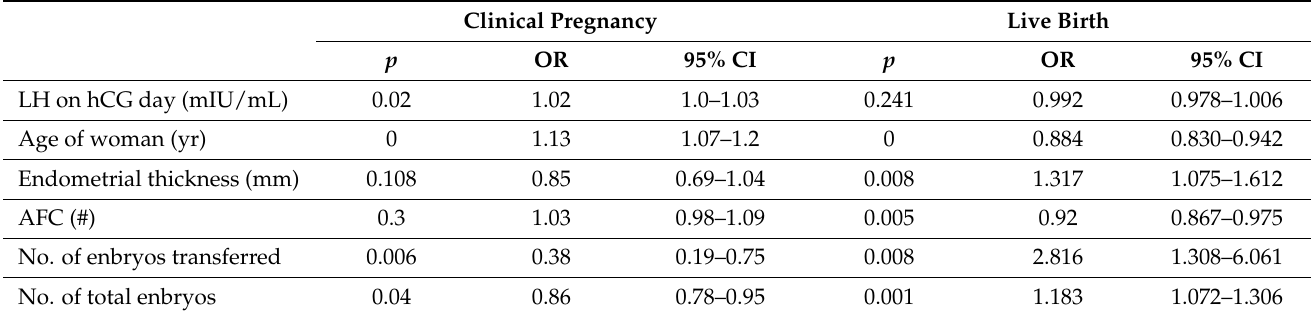
Table 5. Multivariate logistic regression analysis of factors related to clinical pregnancy and live birth. Clinical